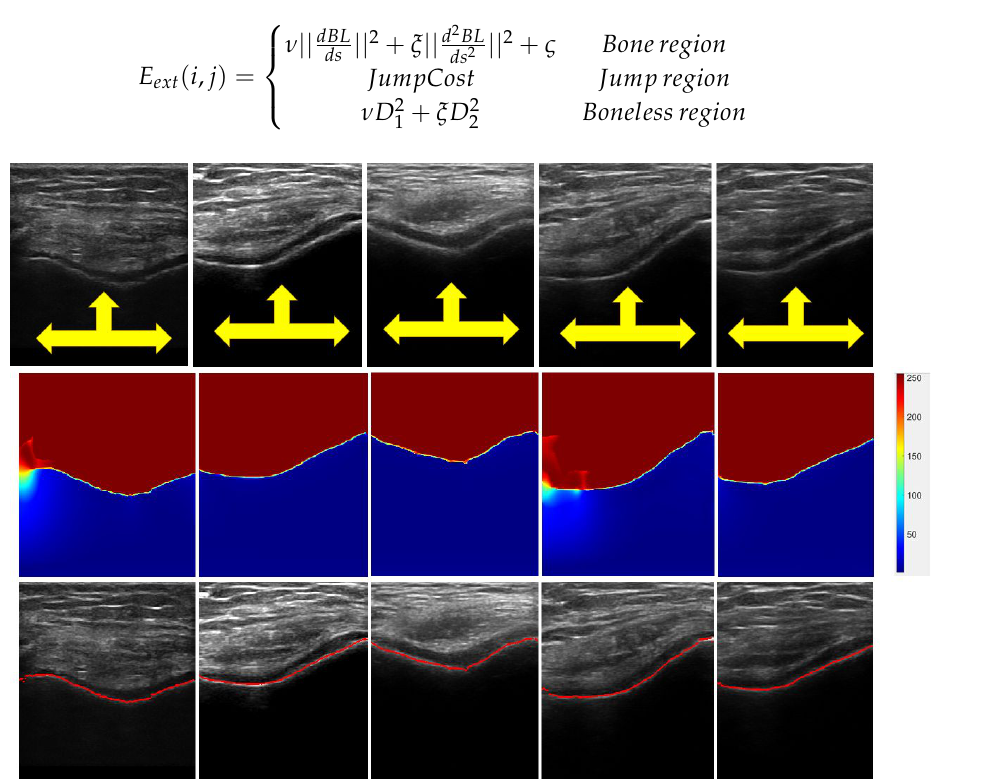
Figure 4. Bone-surface localization results. Top row: B-mode in vivo US knee scans. Yellow arrows show bone-shadow regions. Middle row: Enhanced bone-shadow image BSE ( x , y ) obtained by processing B-mode US scans shown in top row. Soft-tissue interface, red color coding. Bone-shadow regions, blue. Intensity values depict the probability of a signal reaching the transducer imaging array if the signal propagation started at that specific pixel location. The transition region between the soft-tissue and bone-shadow regions represent the expected bone-shadow interface. Bottom row: Localized bone surfaces, shown in red, overlaid on the B-mode US